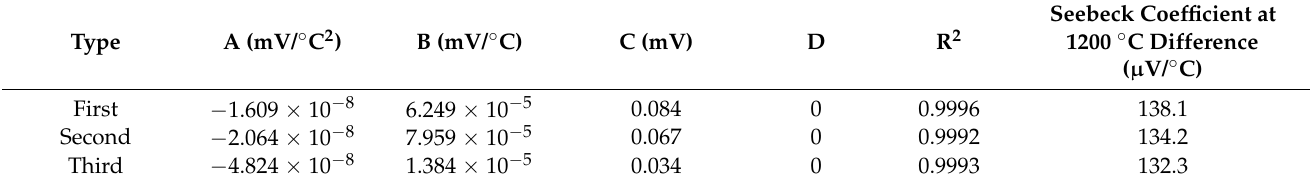
Table 2. Fitting results of output calibration polynomial of ITO/In 2 O 3 thin film